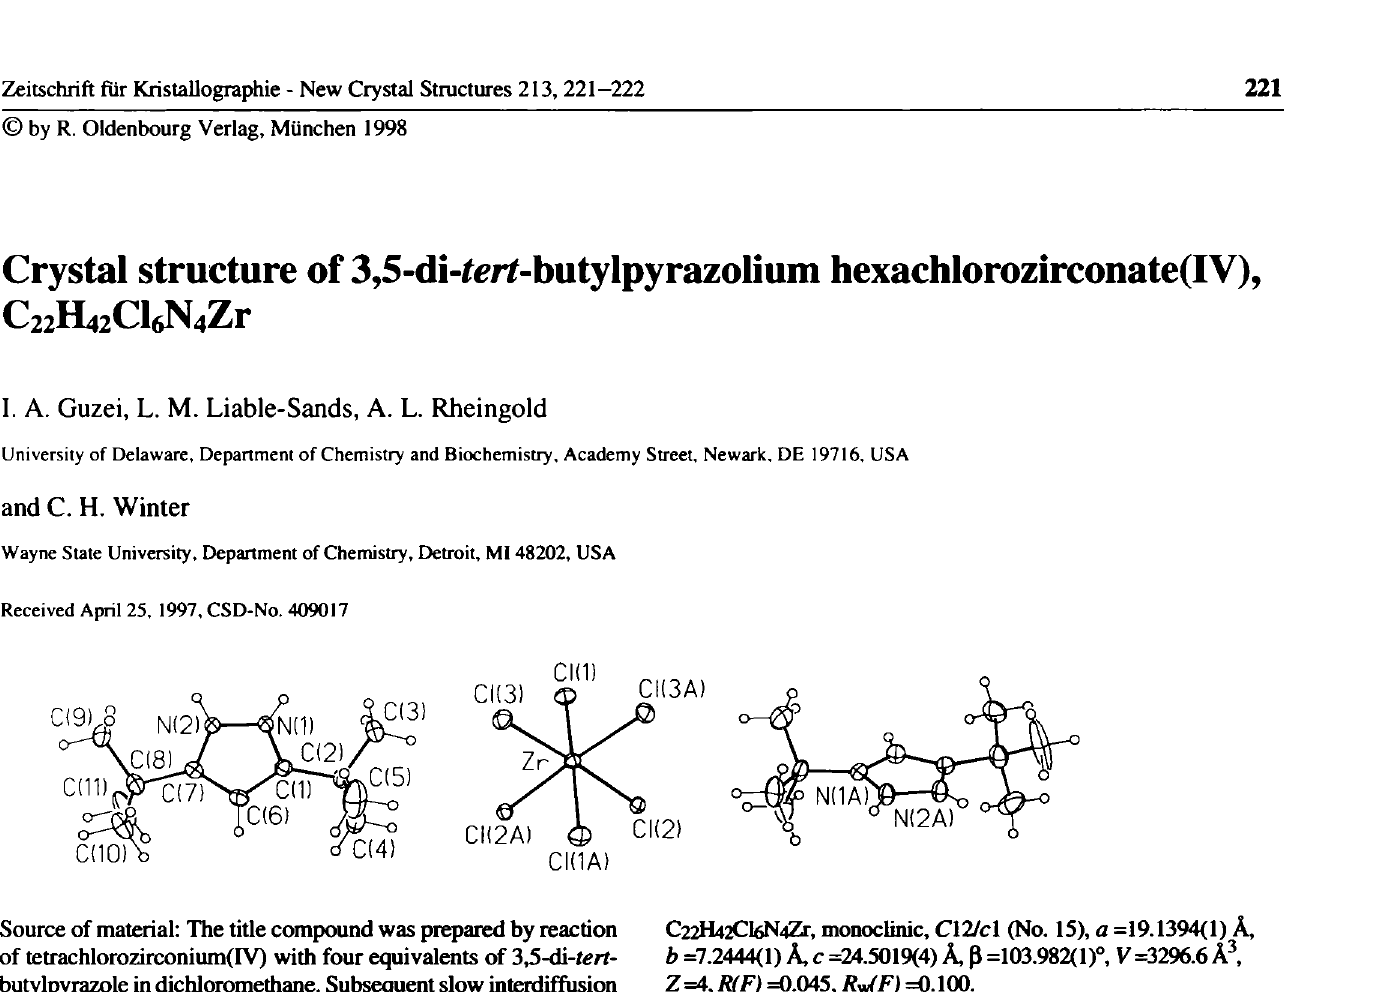
Table 1. Parameters used for the X-ray data collection Crystal: